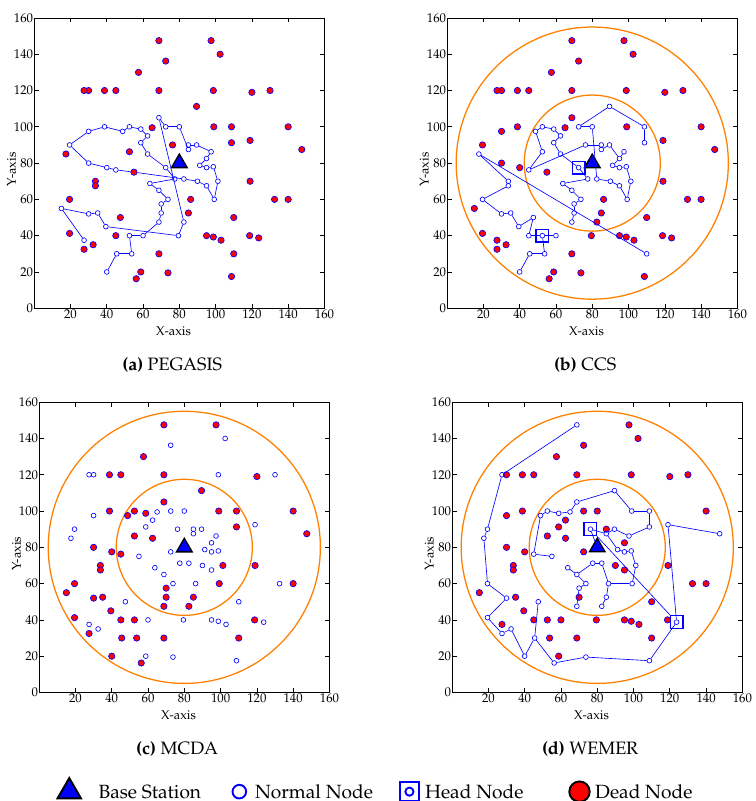
Figure 20. Network topology after Fifty node die (a) at 945 th round for PEGASIS (b) at 951 st round for CCS (c) at 987 th round for MCDA (d) at 1128 th round for WEMER.